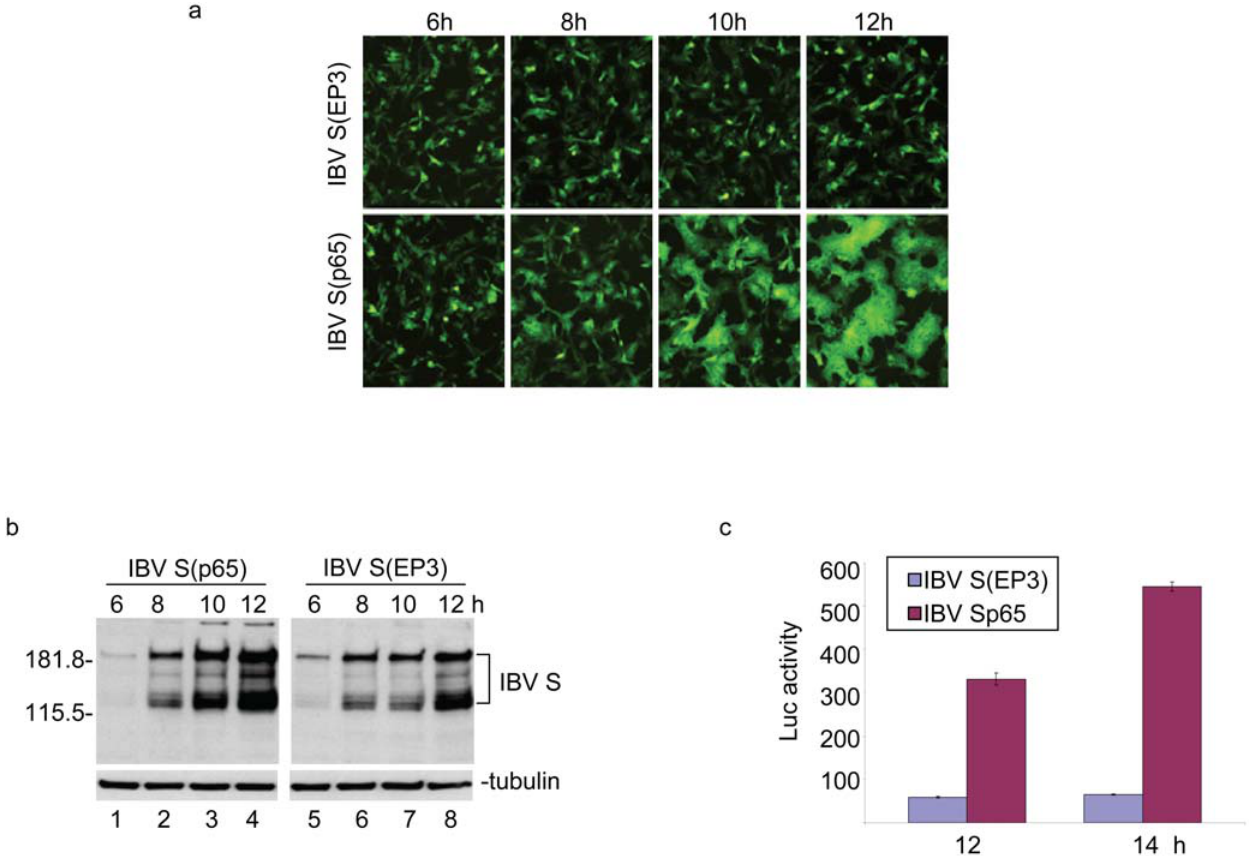
Figure 5. The relationship between the fusogenicity of S protein and its expression level in cells expressing fusion-competent and fusion- incompetent S protein. a. Detection of cell-cell fusion by indirect immunofluorescence. Vero cells were infected with the vaccinia/T7 recombinant virus and transfected with S(EP3) and S(p65) constructs. At 6, 8, 10 and 12 hours post-transfecion, respectively, cells were fixed with 4% paraformaldehyde and stained with rabbit anti-IBV S polyclonal antibodies. b. Expression of fusion-competent and fusion-incompetent IBV S protein. Vero cells were infected with vaccinia/T7 recombinant virus and transfected with S(EP3) and S(p65) constructs. Cells were harvested at 6, 8, 10 and 12 hours post-transfection, respectively, and lysates prepared. The viral protein expression was analyzed by Western blot with rabbit anti-IBV S antibodies. The same membrane was also probed with anti- b -tubulin monoclonal antibody as a loading control. c. Quantitative analysis of the expression of fusion-competent and fusion-incompetent IBV S protein. Vero cells were infected with vaccinia/T7 recombinant virus and transfected with S(EP3)-luciferase and S(p65)-luciferase constructs. Cells were harvested at 12 and 14 hours post-transfection, respectively, lysates prepared, and the luciferase activity was